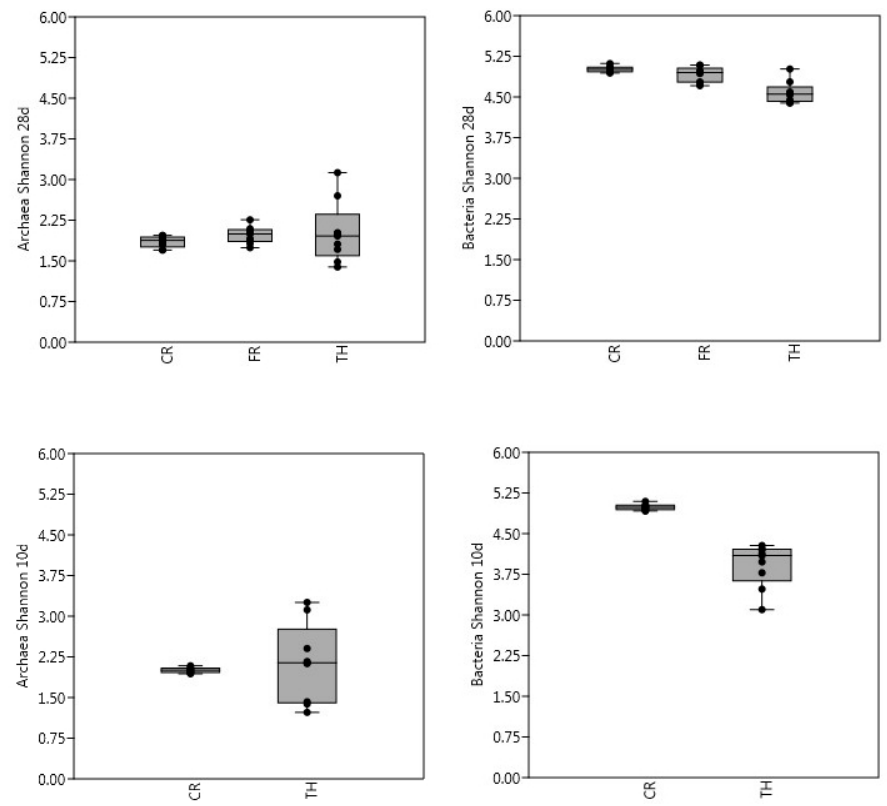
Figure 3. Archaeal and bacterial Shannon diversity index in batch bottles with BW and control (CR), freeze-thaw (FR) and thermally (TH) treated inocula. Length of the experiment was 28 days (treatments CR, FR and TH, figures above) and 10 days (treatments CR and TH, figures below). For each sample, the 25–75 percent quartiles are drawn using a box. The median is shown with a horizontal line inside the box. The minimal and maximal values are shown with short horizontal lines ("whiskers"). The dots are the sample values included.